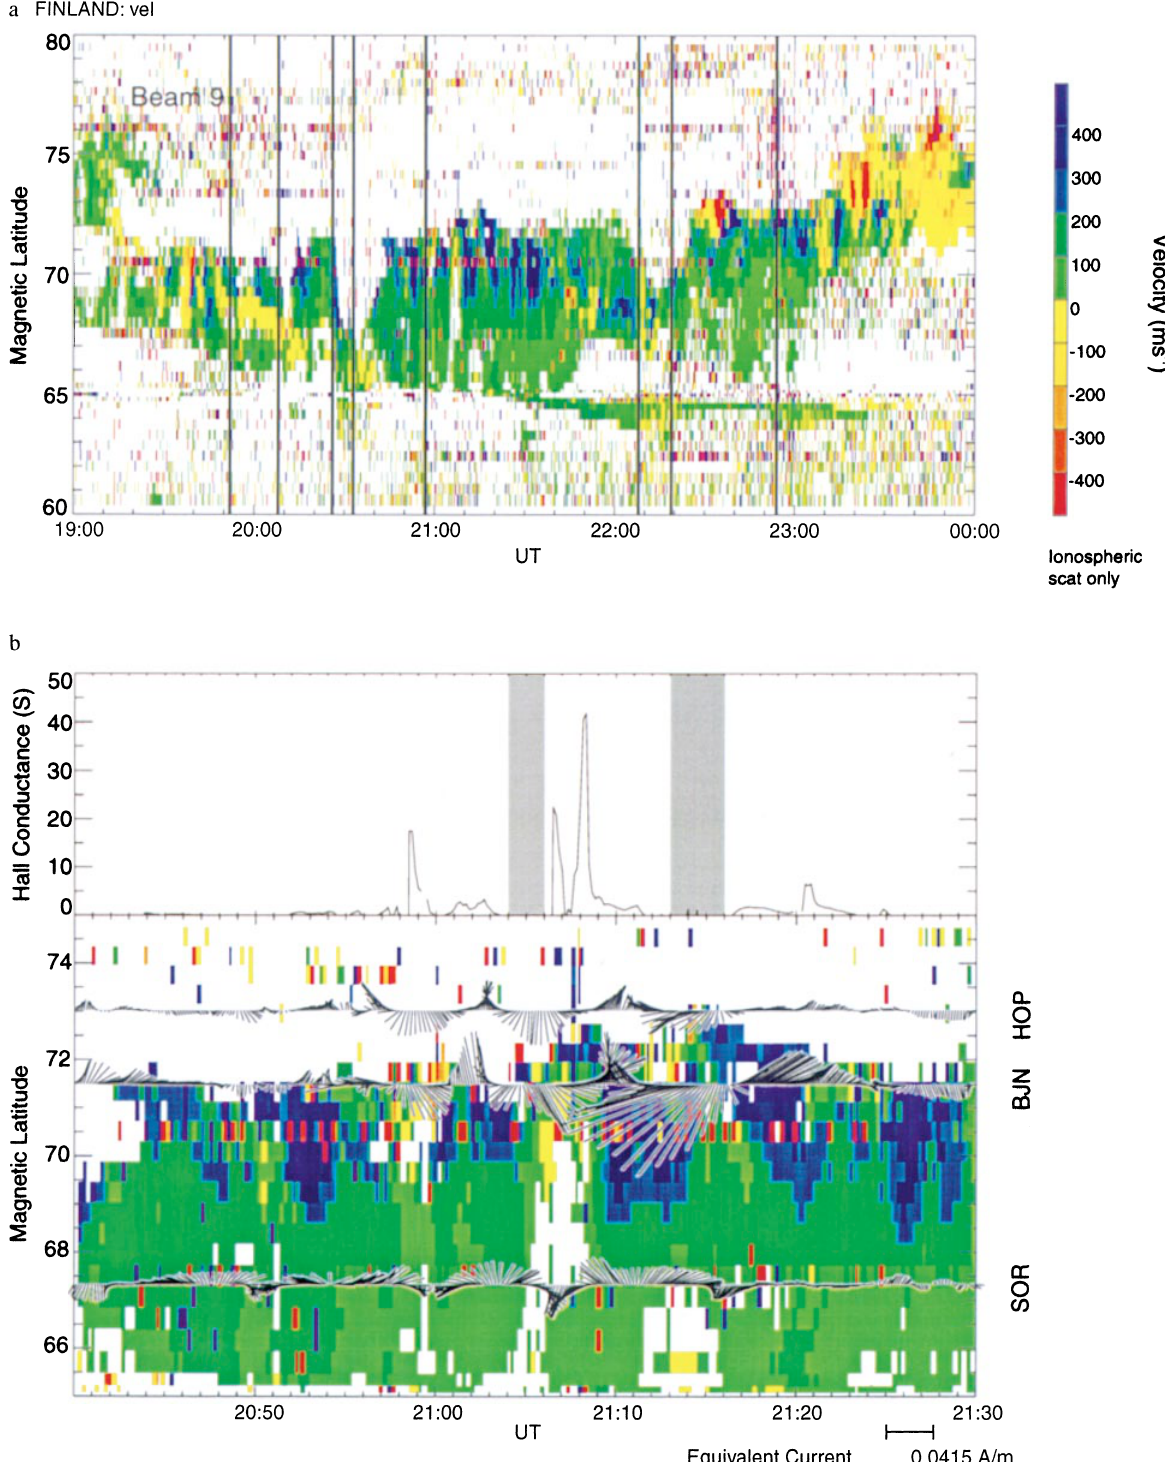
velocities as a function of magnetic latitude and time. The equivalent current intensities derived from the magnetic field data from SOR, BJN and HOP are overlaid at the magnetic latitude appropriate for each station. The upper panel presents an estimate of the Hall conductance, derived from the BJN magnetic field and the line-of- sight velocity from the overlying range gate (see text